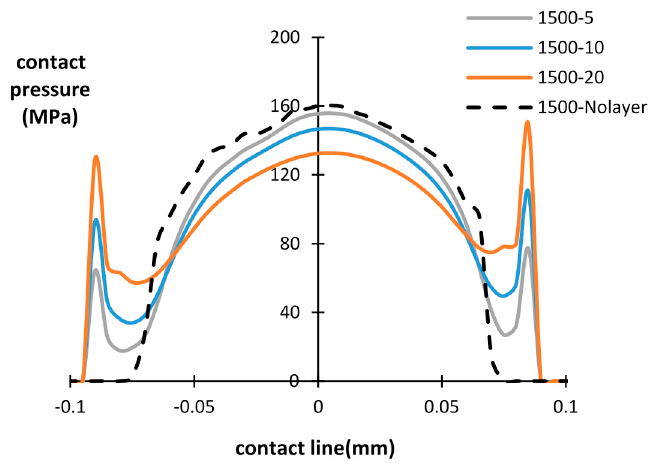
Figure 9. Contact pressure distribution for different layer thicknesses and number of cycles: layer thickness = 5 µm, 10 µm, 20 µm and without layer after 1500 cycles.